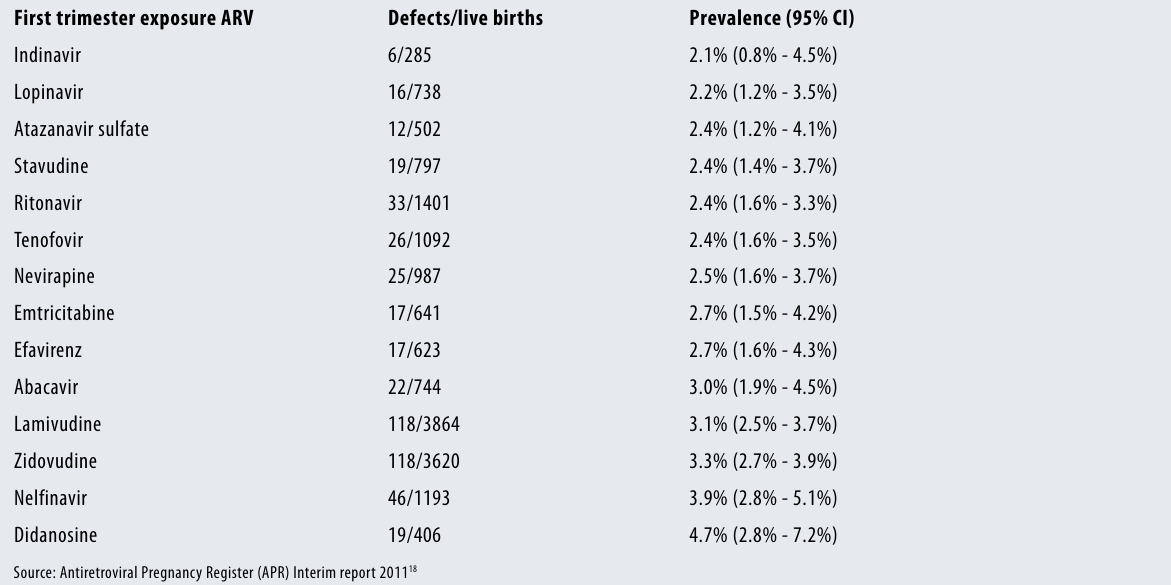
taBle 2. comparatIve rates of BIrth Defects for wIDely useD arvs In the fIrst trImester first trimester exposure